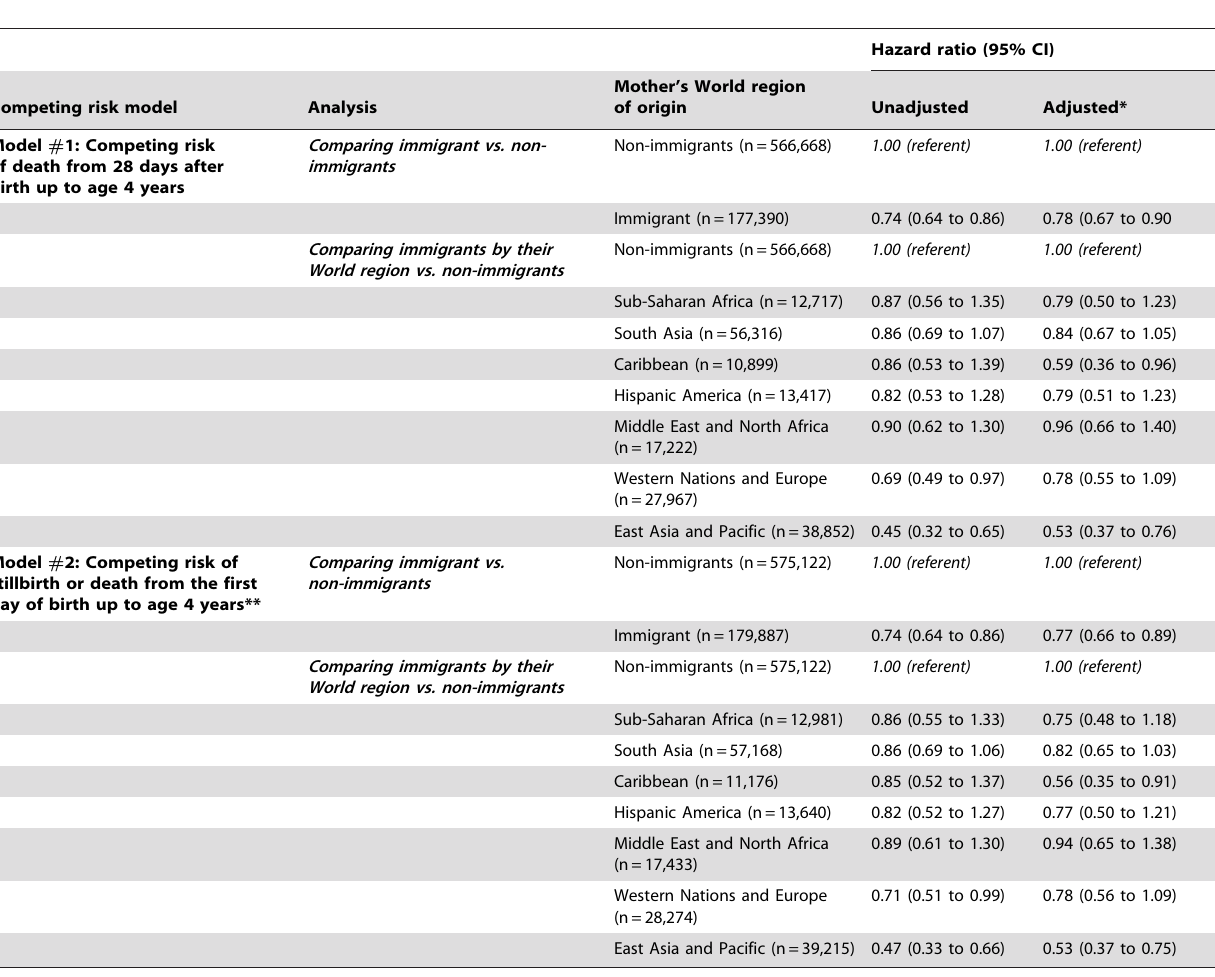
Table 3. Competing risk models for cerebral palsy accounting for death from 28 days after birth up to age 4 years (upper), as well as for stillbirth or death from the first day of birth up to age 4 years (lower), in association with maternal World region of origin.